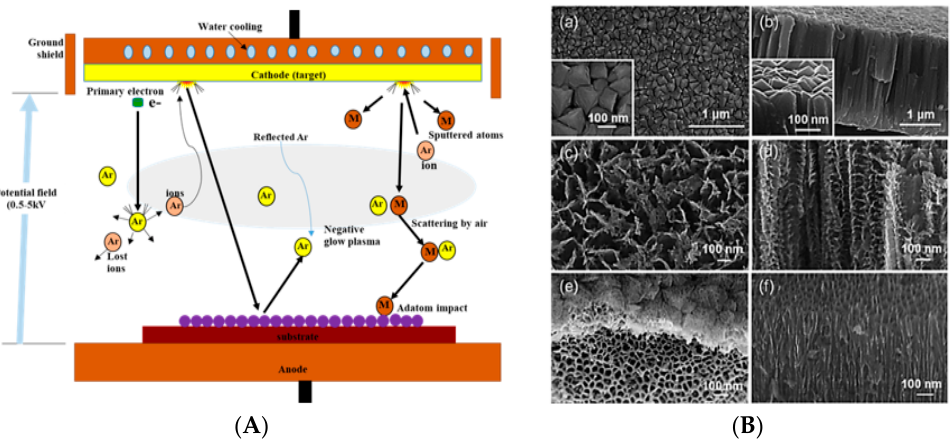
Figure 9. ( A ) Schematic diagram of the sputtering deposition process. ( B ) SEM images showing the